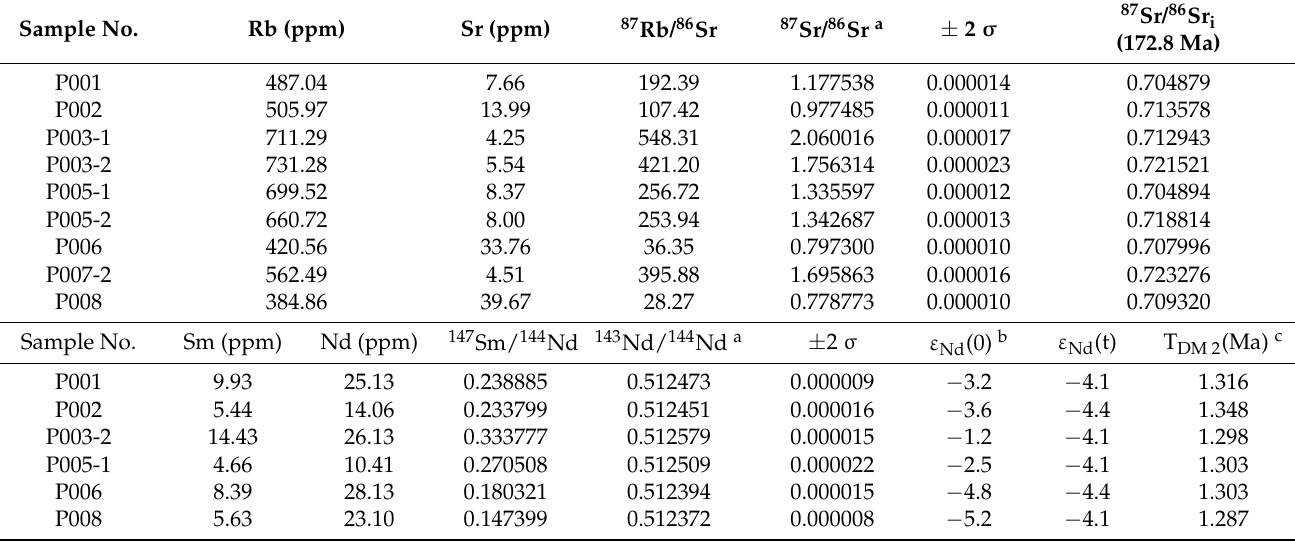
Table 3. Whole-rock concentrations and Rb-Sr and Sm-Nd isotopic parameters of Pirrit Hills granite samples. Sample No.